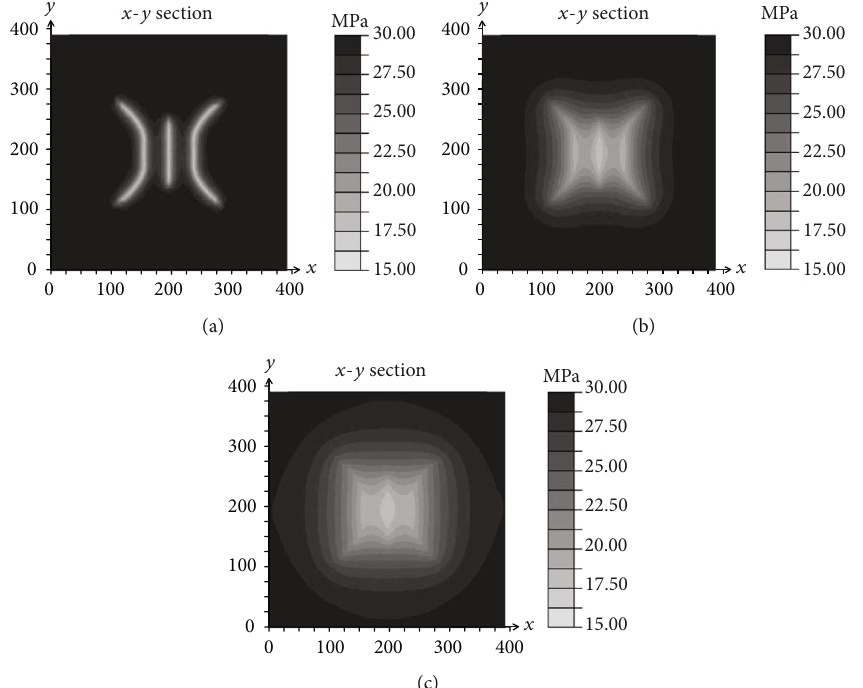
Figure 15: (a), (b), and (c) present the pore pressure distribution after 1, 5, and 10 years of nonplanar fracture production without considering the in fl uence of natural